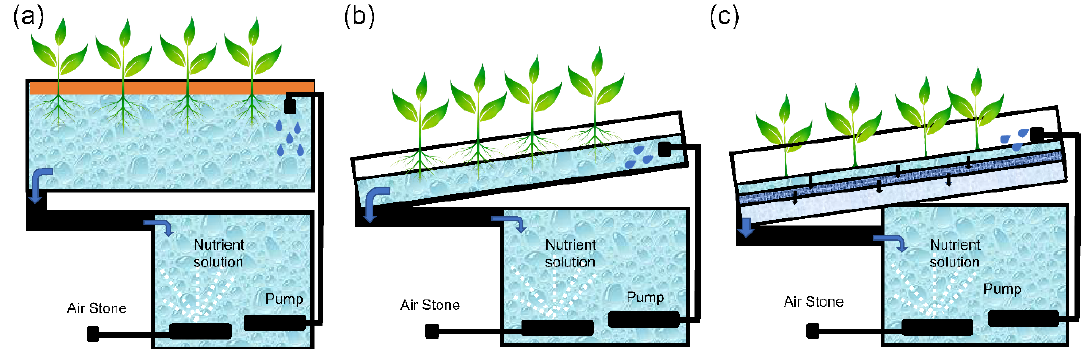
Figure 3. Hydroponic cultivation systems. ( a ) Deep floating technique (DFT) system, ( b ) nutrient film technique (NFT) system, and ( c ) new growing system technique (NGST).